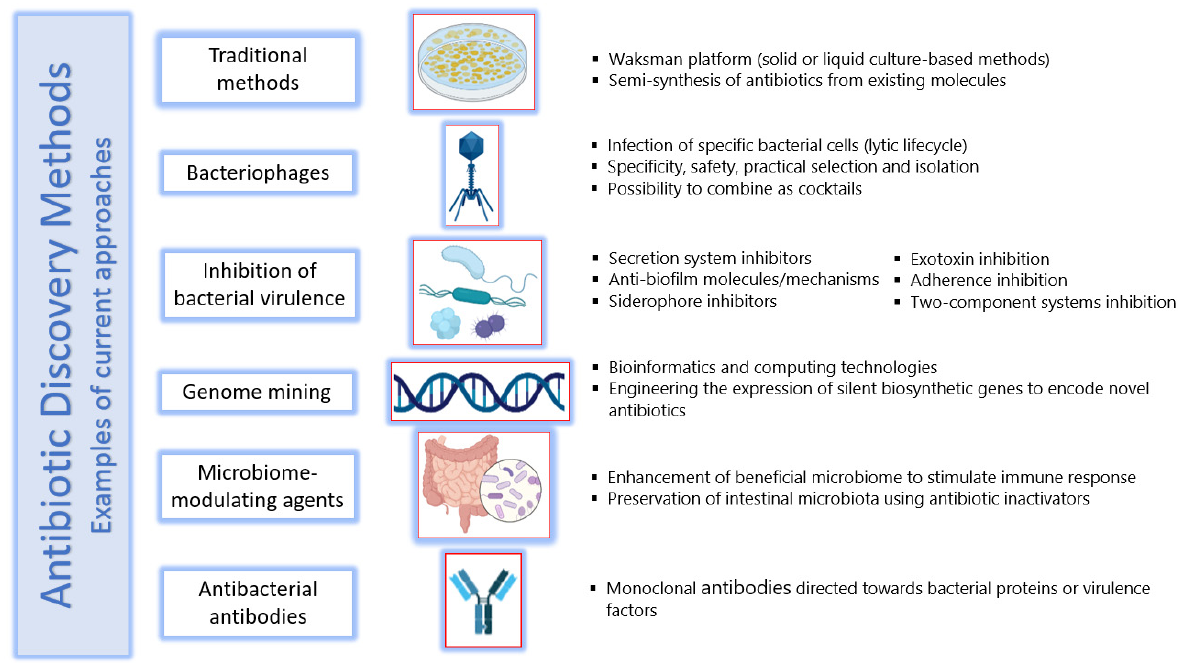
Figure 4. Concise representation of some antibiotic discovery methods and new approaches to design therapies that circumvent antimicrobial resistance. Photos were prepared using Biorender.com (accessed on 20 January 2022)